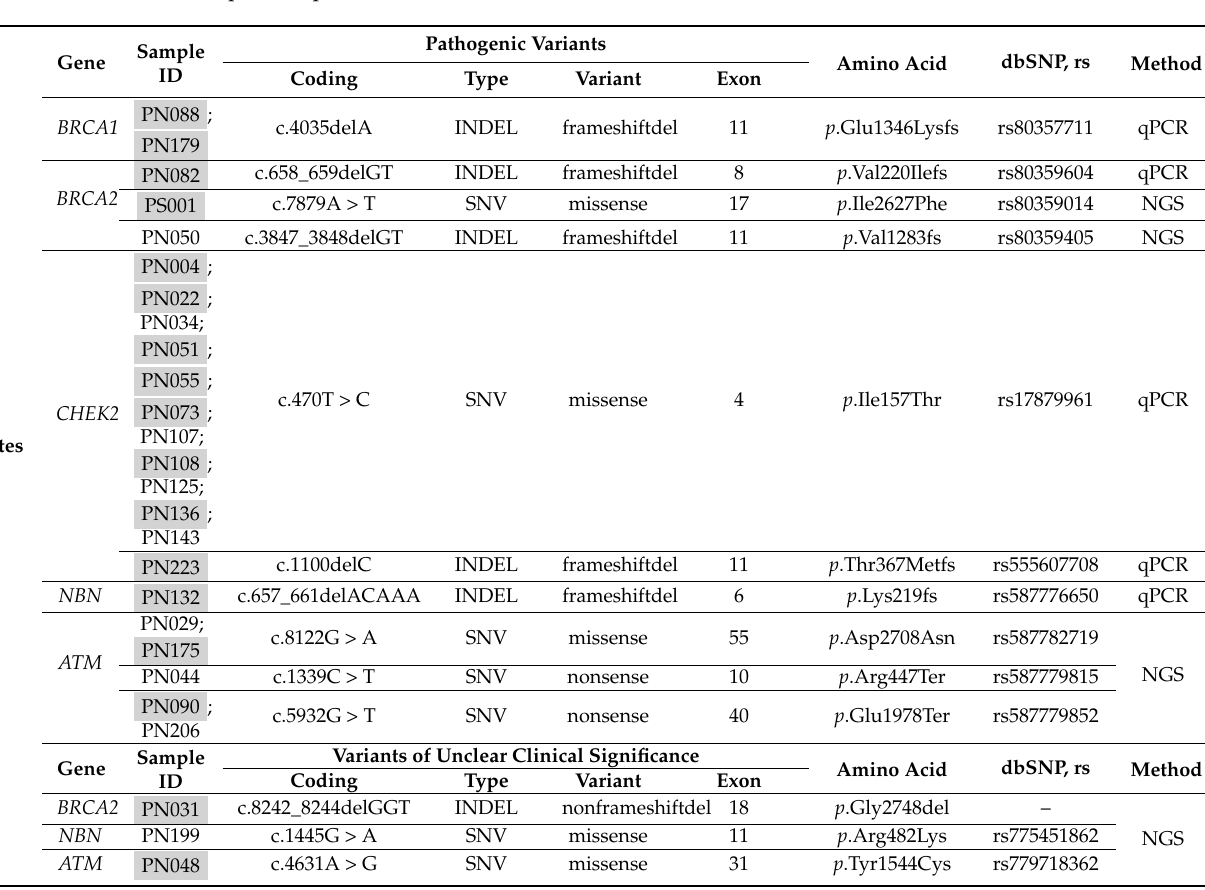
Table 1. Molecular characteristics of variants of pathogenic or unclear clinical significance in mutation- positive